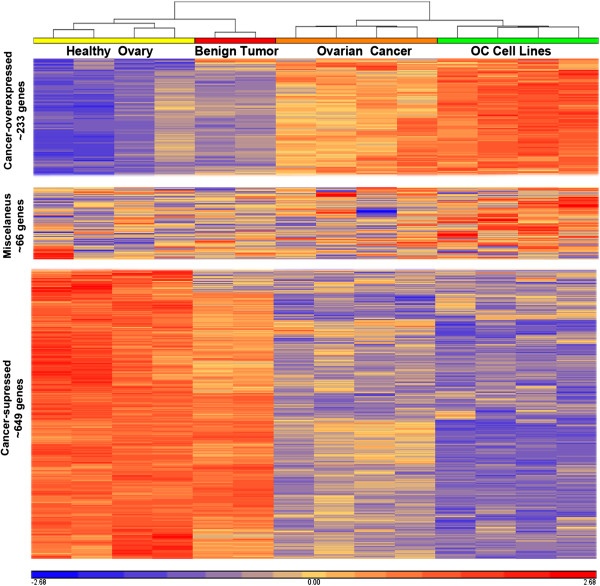
Hierarchical clustering of ovarian cancer gene. Heat maps depicting hierarchical clustering of gene expression in healthy ovarian tissue, benign ovarian tumours, ovarian cancer and ovarian cancer cell lines. Graphics were generated by means of Partek Genomics Suite™ software. Differentially expressed gene values were included only when fold-change was > 3 and false discovery ratio < 0.005 and only the number of genes clustering to over- expression (top), no significant changes (middle) and under-expression (bottom) are shown. Gene names, RefSeq, and other details are shown in Additional file 2.